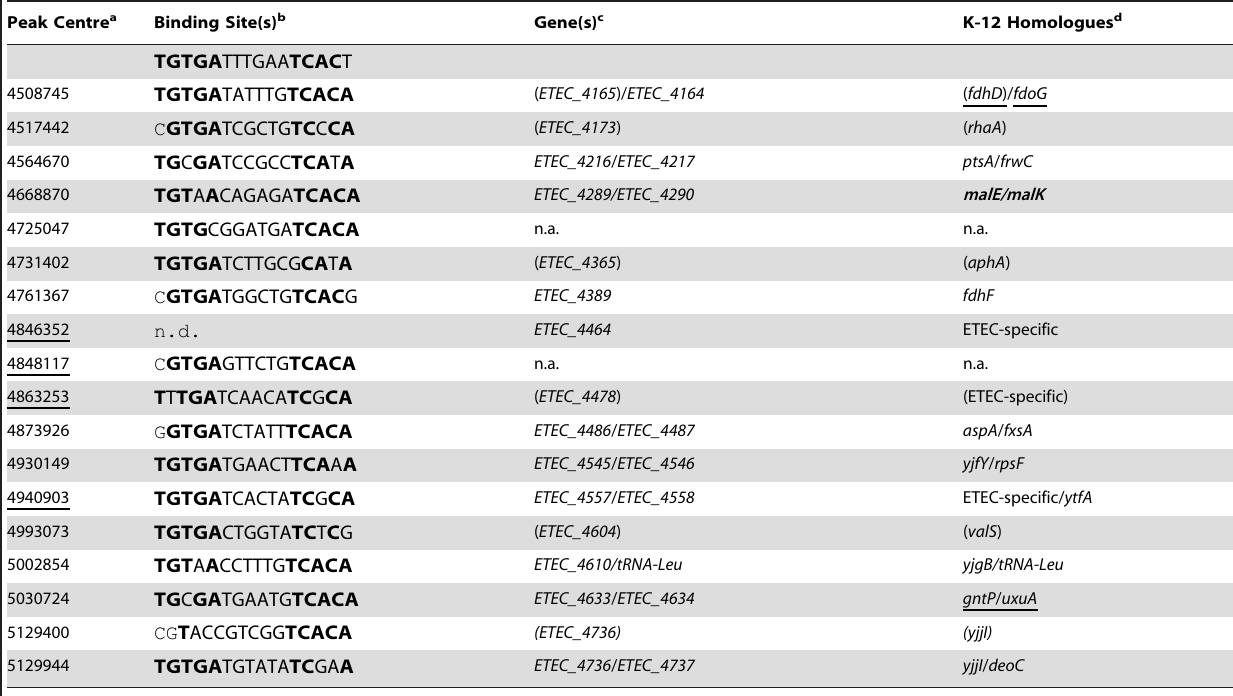
Peak Centre a Binding Site(s)